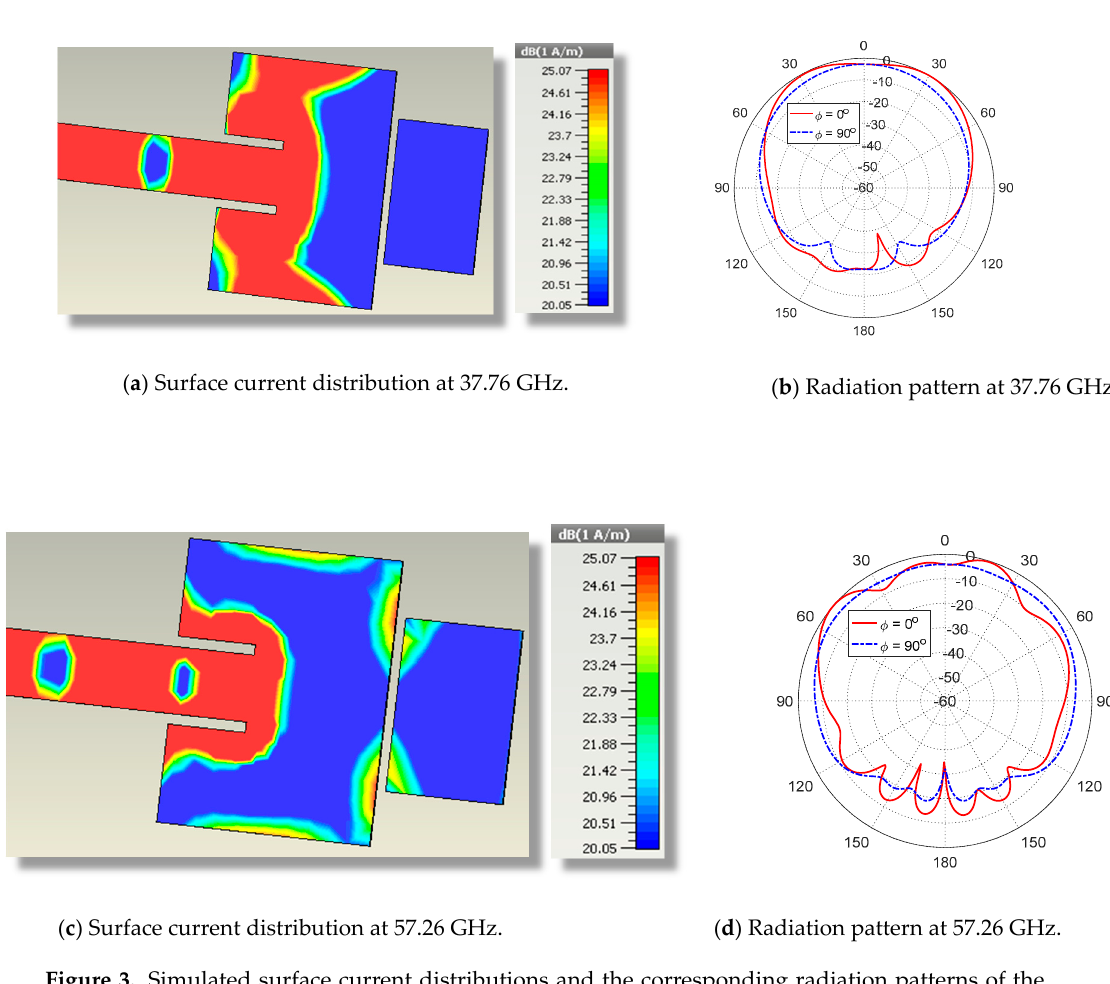
Figure 3. Simulated surface current distributions and the corresponding radiation patterns of the proposed dual-band patch antenna at 37.76 GHz and 57.26 GHz .